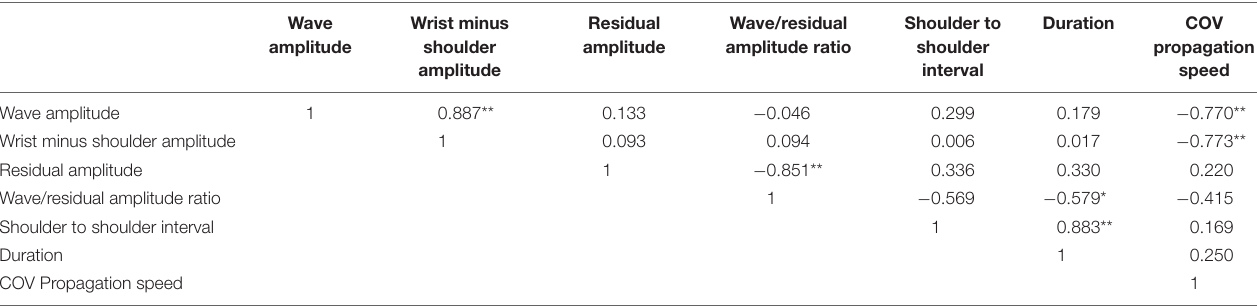
FIGURE 4 | Sequential joint articulation and differentiation expressed in terms of internal (blue) and external (orange) foci of attention. The hand amplitudes in all participants were larger than the shoulder amplitudes. Differences can be seen in a small and modest wave pattern (participant 9) vs. a large more pronounced wave pattern (participant 6). TABLE 1 | Pearson’s correlations of the chosen kinematic variables (see